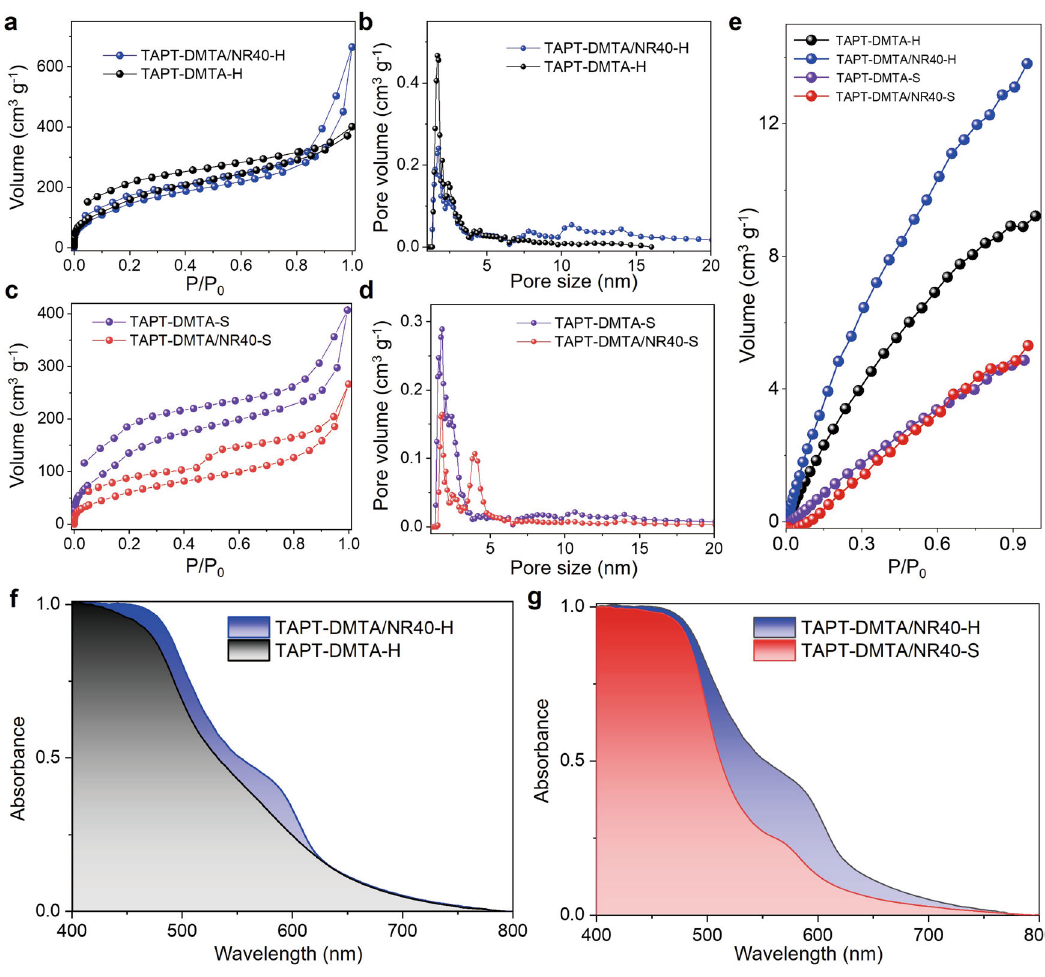
Fig. 2 | Gas adsorption and light absorption properties. The N 2 adsorption- desorption isotherms ( a ) and pore size distributions ( b ) of TAPT-DMTA-H and TAPT-DMTA/NR40-H. The N 2 adsorption-desorption isotherms ( c ) and pore size distributions ( d ) of TAPT-DMTA-S and TAPT-DMTA/NR40-S. The CO 2 adsorption